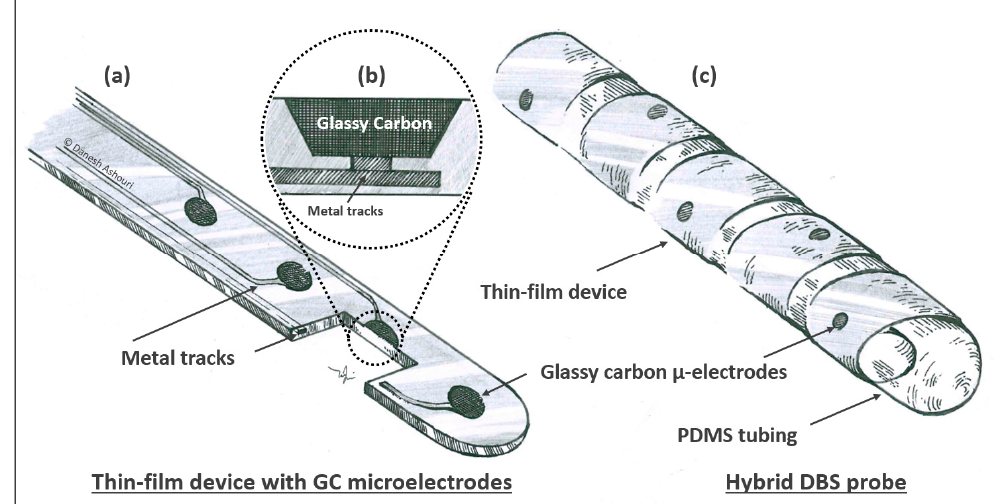
Figure 2. Schematic of the hybrid deep brain stimulation (DBS) probe. ( a ) Thin-film device with glassy carbon (GC) microelectrodes (50 um in diameter) embedded into a polyimide substrate. The active sites are distributed homogeneously along the length of the foil; ( b ) Cross-sectional view of the interface between the glassy carbon and the metal tracks ( c ) Assembled hybrid probe showing the spiral design of the wrapped thin-film device shown in ( a ) around the silicone-rubber tubing (diagram by D. Ashouri Vajari).